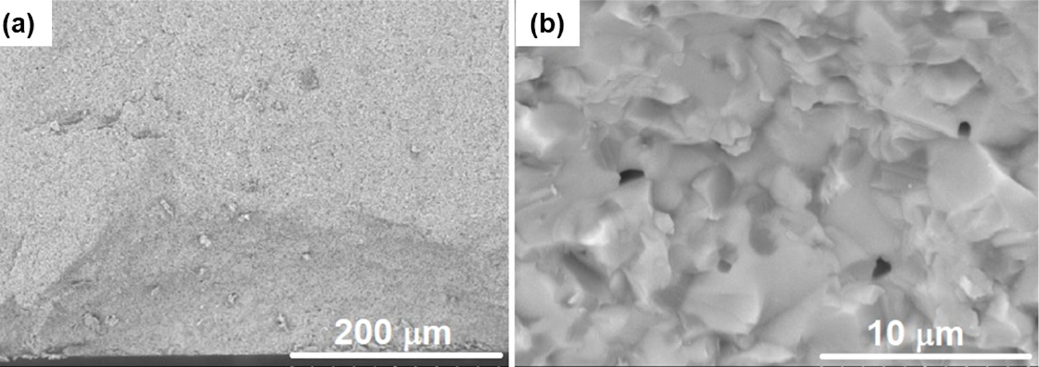
Figure 7. Characteristic fracture surface of the CZM material at ( a ) low magnification (250×), and ( b ) high magnification (5000×).